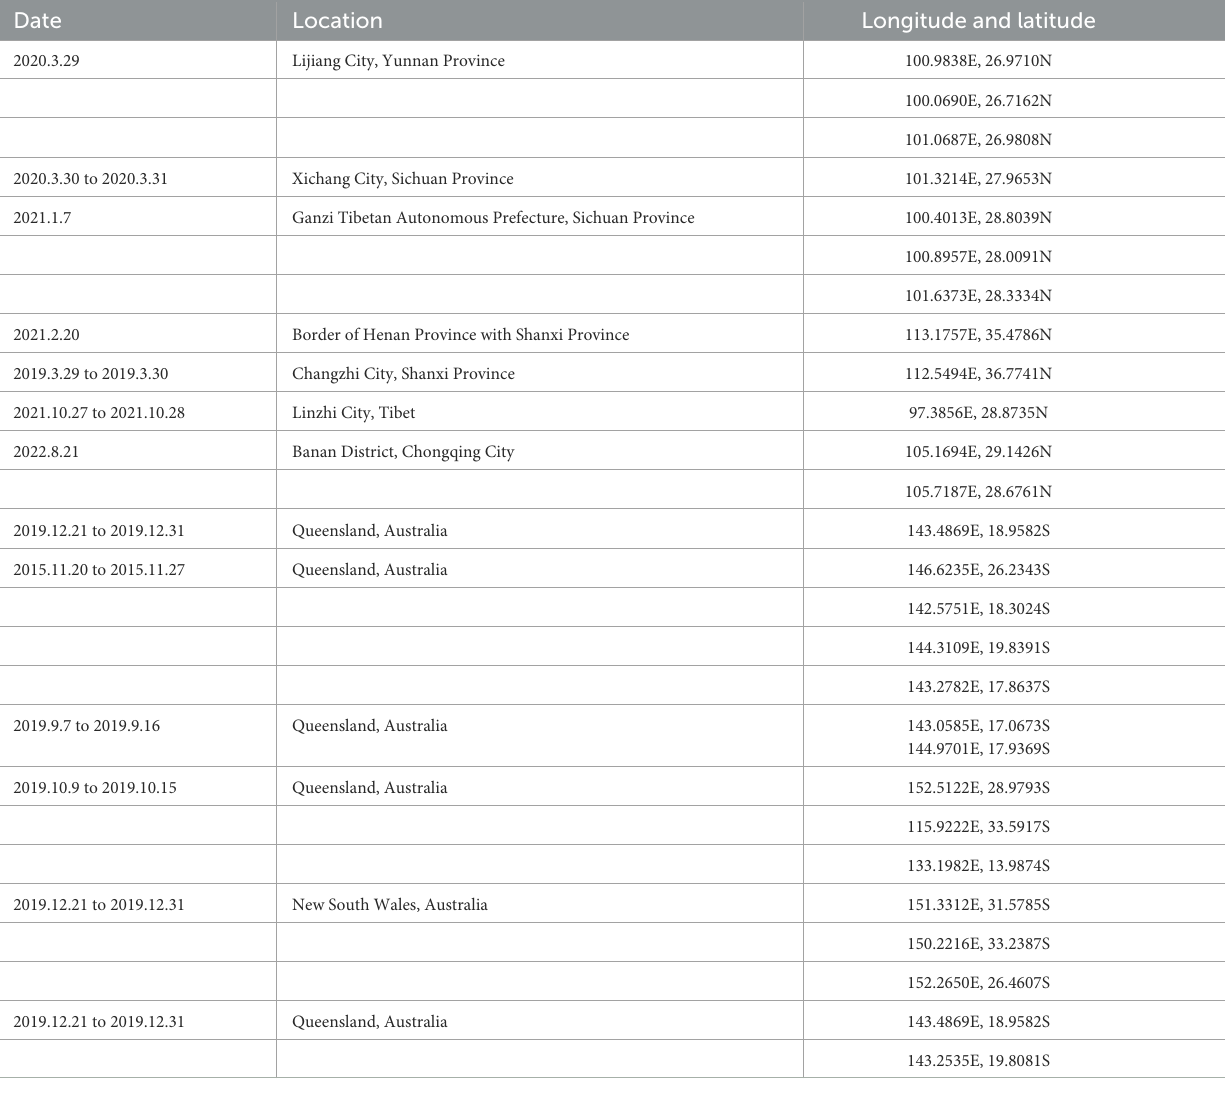
TABLE 1 Specific acquisition information of date, location, longitude, and latitude of remote sensing images containing forest fire smoke.